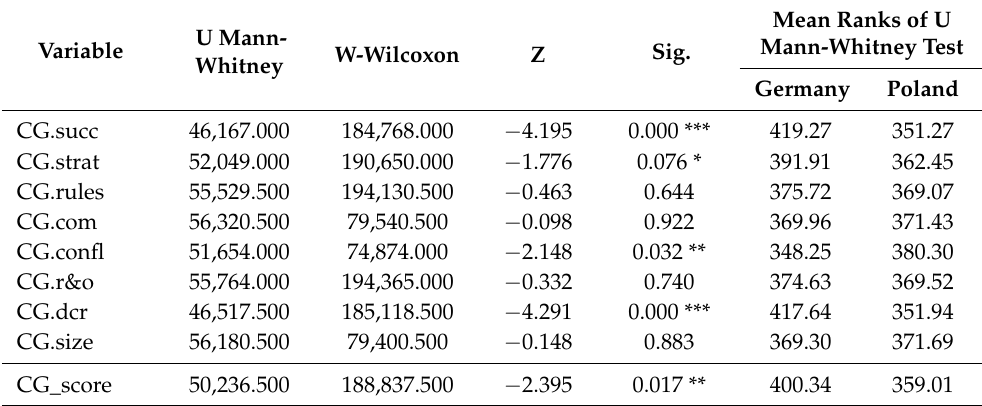
Table 8. Strength of corporate governance mechanisms construct: SMEs in Germany vs. SMEs in Poland. U Variable